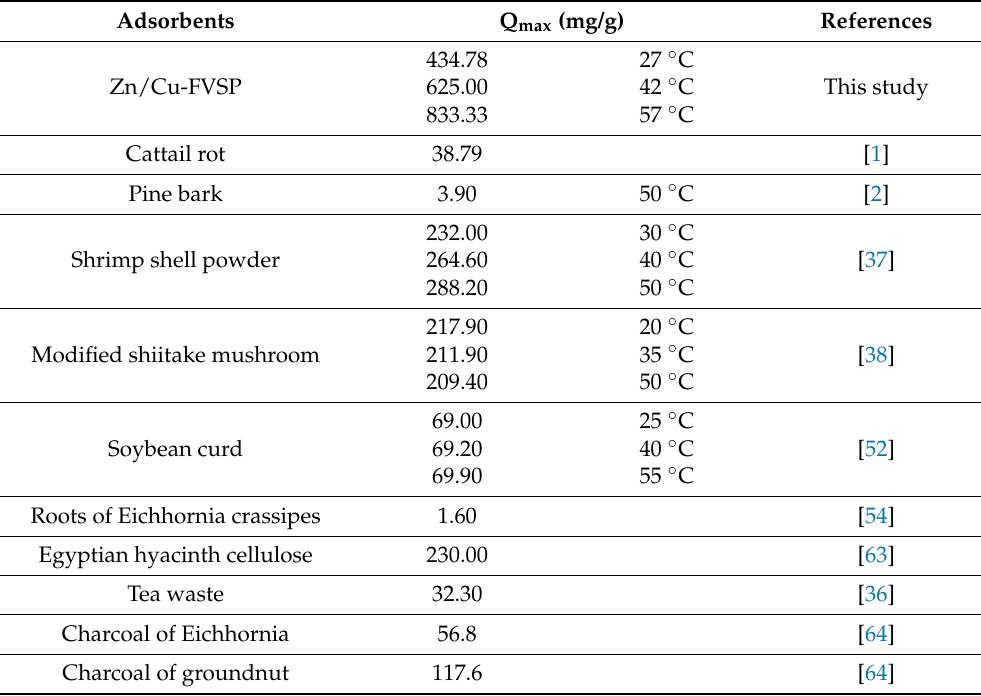
Table 6. Q max values of CR adsorption onto Zn/Cu-FVSP and other low-cost adsorbents used in the prior